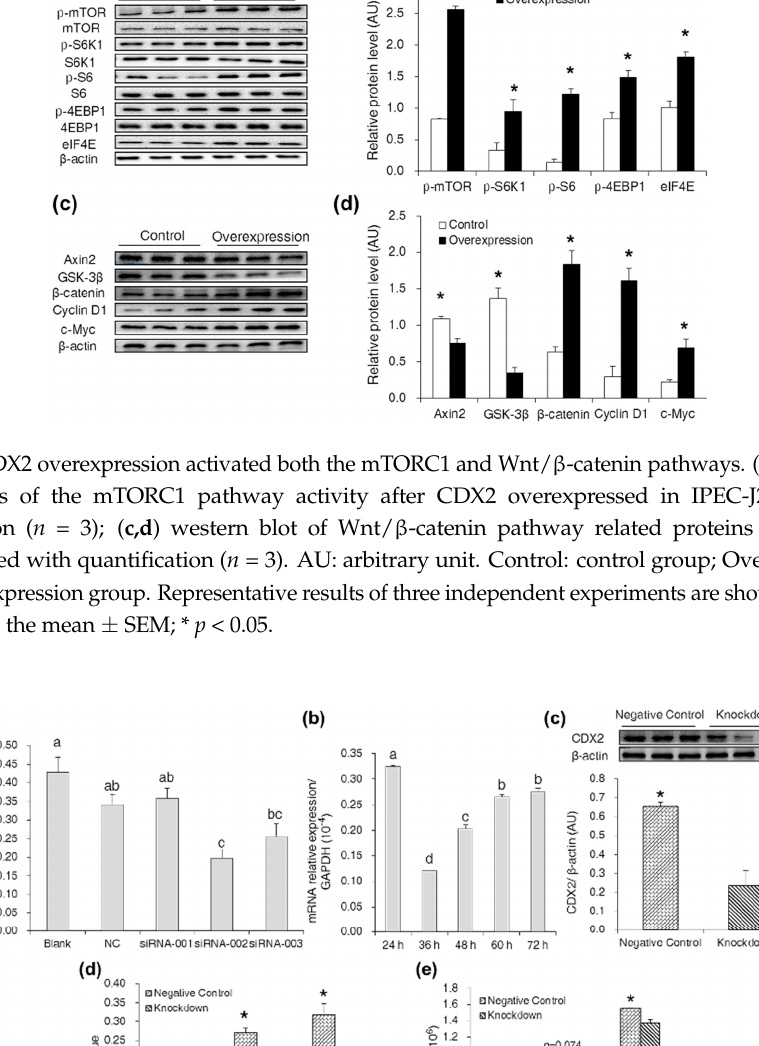
Figure 3. CDX2 knockdown in IPEC-J2 cells reduced cell proliferation. ( a ) The effect of three siRNAs on CDX2 mRNA abundance was measured by real-time PCR 48 h post-transfection. Blank: control group; NC: negative control group; siRNA-001: CDX2-siRNA-001 group; siRNA-002: CDX2-siRNA-002 group; siRNA-003: CDX2-siRNA-003 group; ( b ) the effect of siRNA-002 transfection time on CDX2 mRNA abundance was measured by real-time PCR. Data are expressed as the mean ± SEM ( n = 6). The bars without same letters indicate a significant difference ( p < 0.05); ( c ) siRNA-002 treatment reduced CDX2 protein expression compared with the negative control group. AU: arbitrary unit; ( d,e ) OD values and cell numbers were assessed by MTT assay ( n = 20) and cell counting ( n = 6), respectively. Negative Control: negative control group; Knockdown: CDX2-siRNA-002 group. Representative results of three independent experiments are shown. Data are expressed as the mean ± SEM; * p < 0.05.